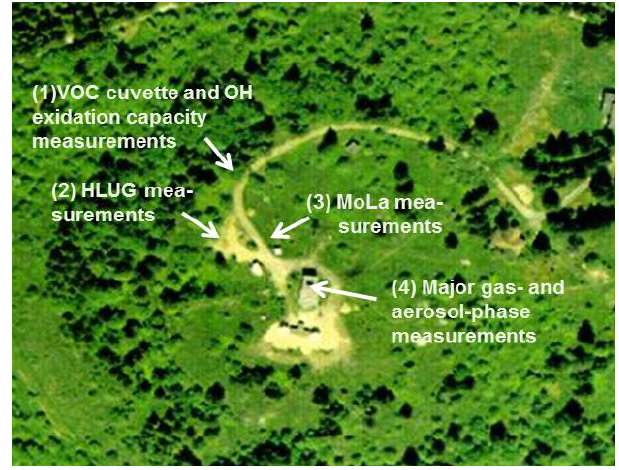
Figure 2. Campaign site and locations of individual